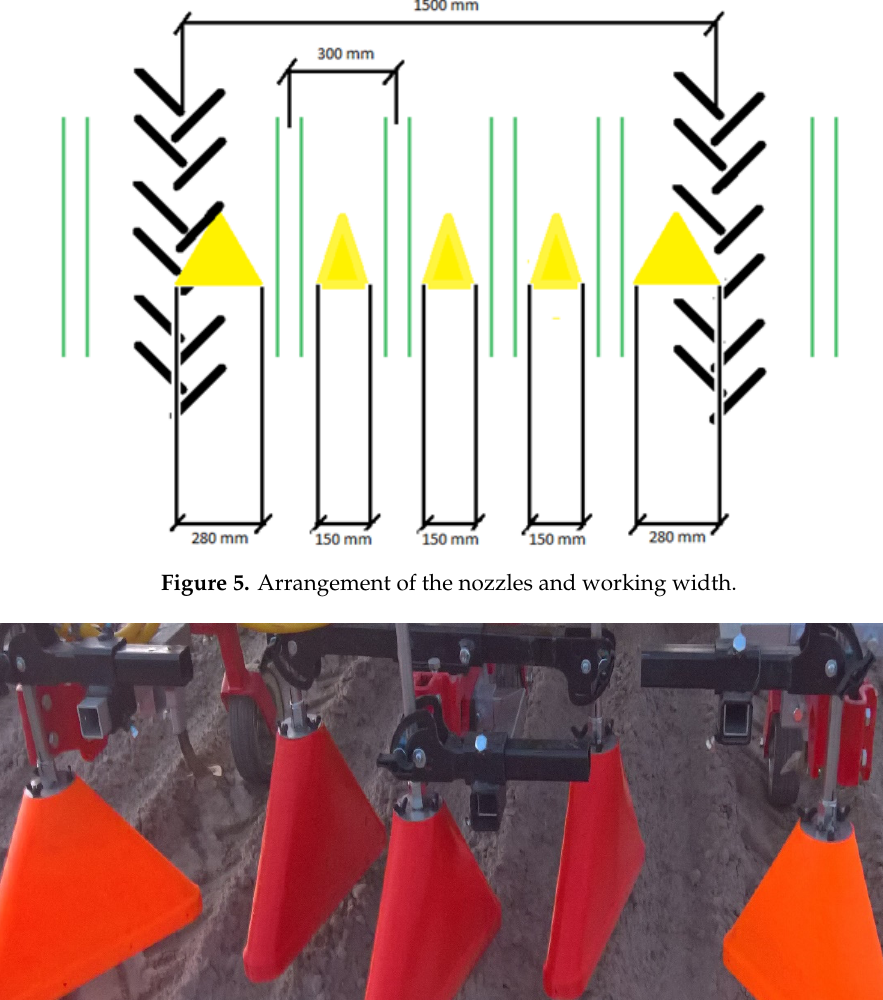
Figure 5. Arrangement of the nozzles and working width.